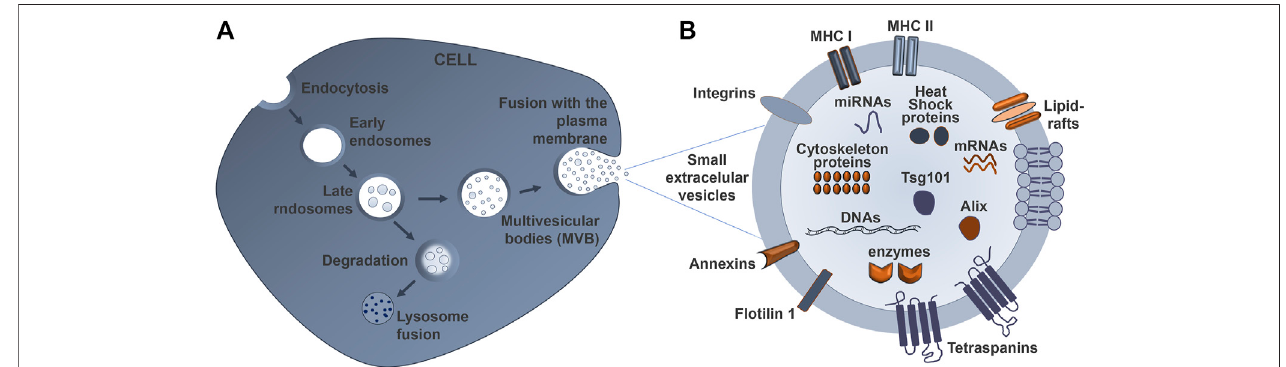
FIGURE 2 | Schematic representation of sEV biogenesis and its typical structure. (A) Early endosomes mature into late endosomes named multivesicular bodies (MVBs), which are formed after inward budding of the plasma membrane. The MVBs can either fuse with lysosomes to degrade their cargo, or fuse with the cell membranetoreleasesmallextracellularvesicles(sEVs)intotheextracellularspace,thusmediatingcell-to-cellcommunication. (B) ThesEVislimitedbyalipidbilayerthat includes ceramide sphingolipids and phospholipids. The sEV membrane also contains various proteins involved in the antigen presentation (major histocompatibility complexes – MHC I and II), as well as targeting and adhesion (integrin and tetraspanins) proteins, together with annexins. The cytosol content of the sEVs varies according to the cell and tissue from which they derive, and may contain lipids, nucleic acids, and proteins, among other